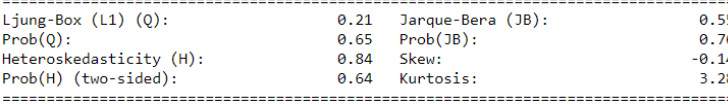
Figure 11. Statistical indicators of the model.